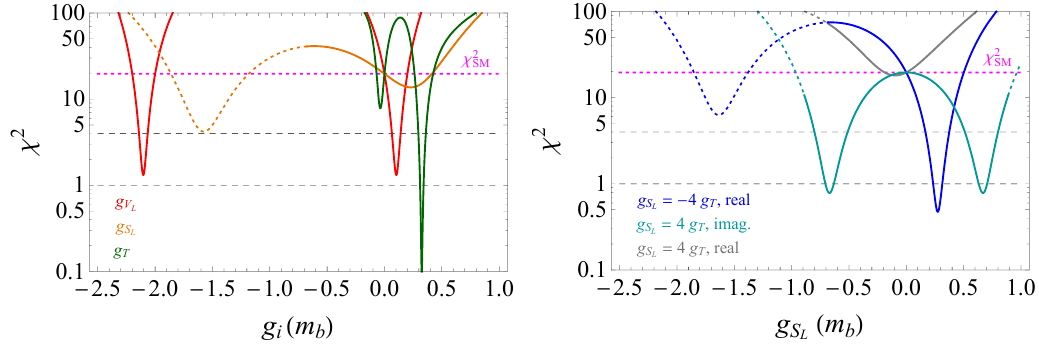
Figure 2 . (cid:31) 2 values for individual e(cid:11)ective coe(cid:14)cients (cid:12)ts of R D and R D (cid:3) , compared to the SM value, (cid:31) 2 (cid:25) 19 : 7. In the left panel, (cid:31) 2 is plotted against g V , g S and g T at (cid:22) = m b . In the SM L L right panel, (cid:31) 2 is plotted against g S ( m b ) by assuming g S = (cid:6) 4 g T at (cid:22) = 1 TeV, for purely L L imaginary and real couplings. The dashed regions correspond to the values excluded by the B c - lifetime constraints, see text for